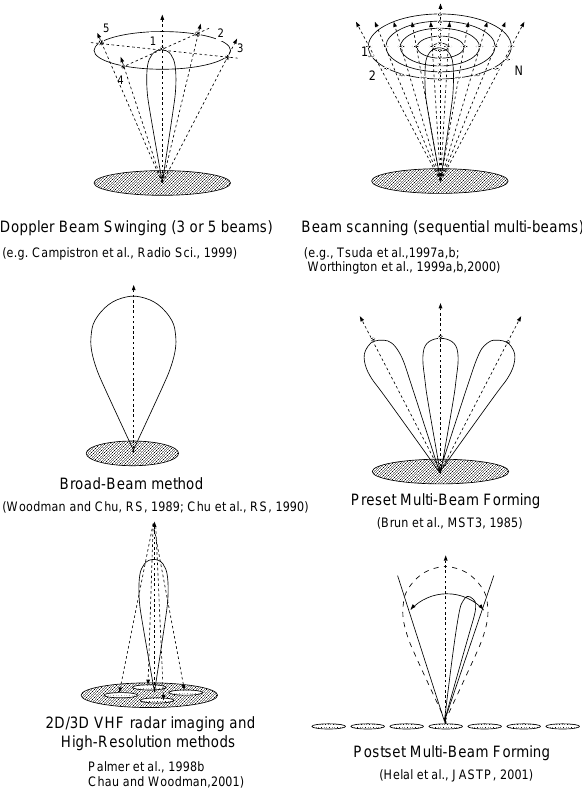
Fig. A1. Schematic representation of the different techniques that can be used for the study of aspect